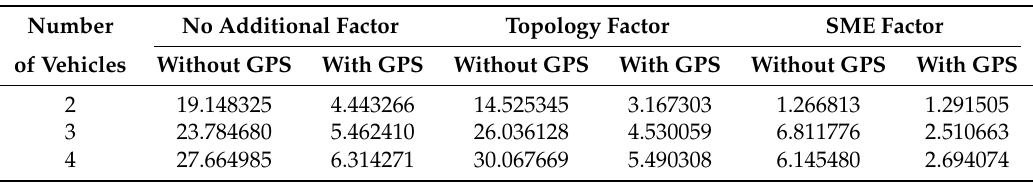
Table 1. Average RMSE for 1000